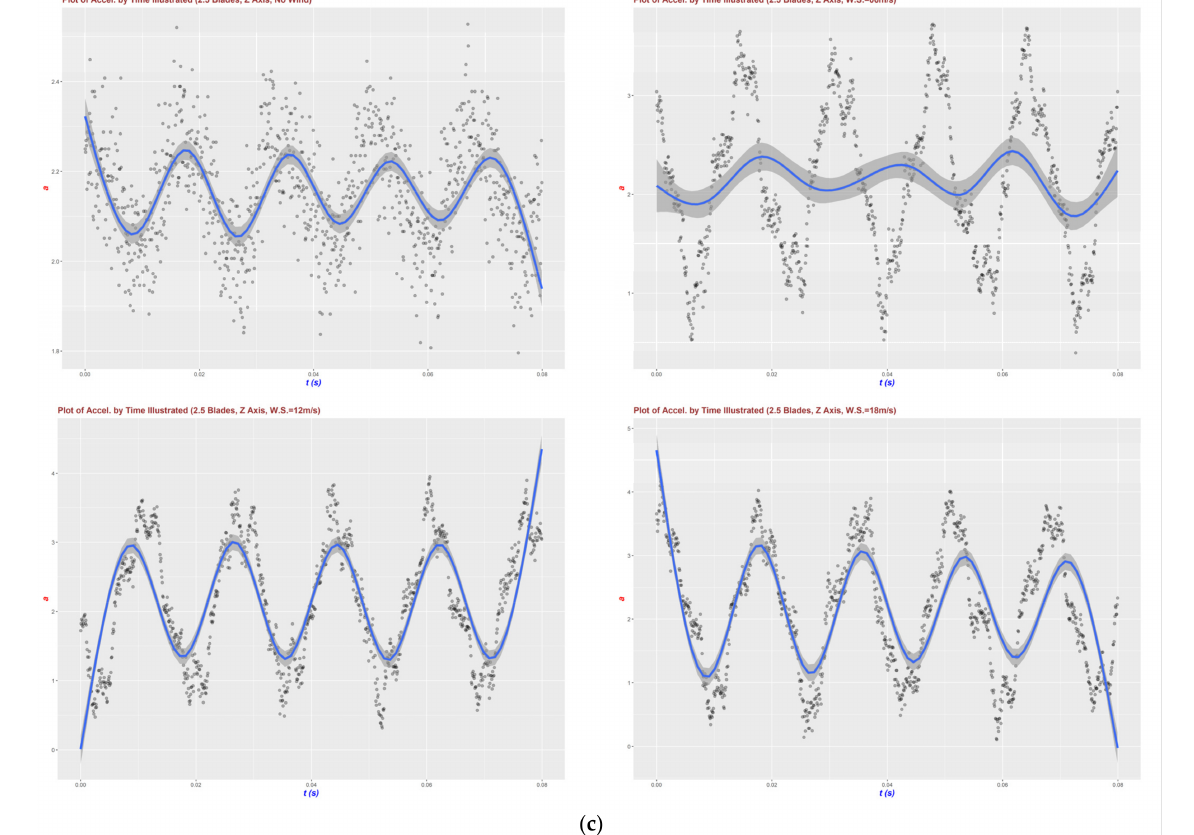
Figure A5. Magnitude and trend of acceleration for the 2.5-blade (partially broken) turbine. ( a ) Based on datasets recorded along the X axis with different wind-speeds imposed. ( b ) Based on datasets recorded along the Y axis with different wind-speeds imposed. ( c ) Based on datasets recorded along the Z axis with different wind-speeds